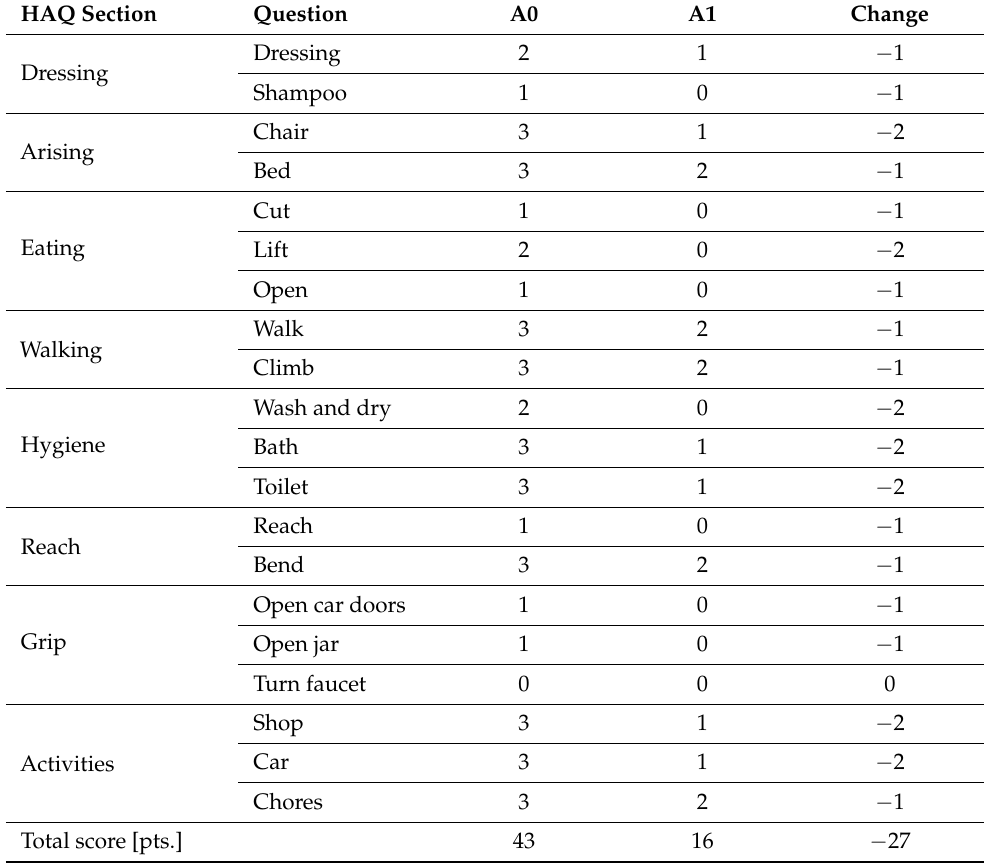
Table 3. Disability level assessment using the HAQ scale before and after rehabilitation. HAQ Section